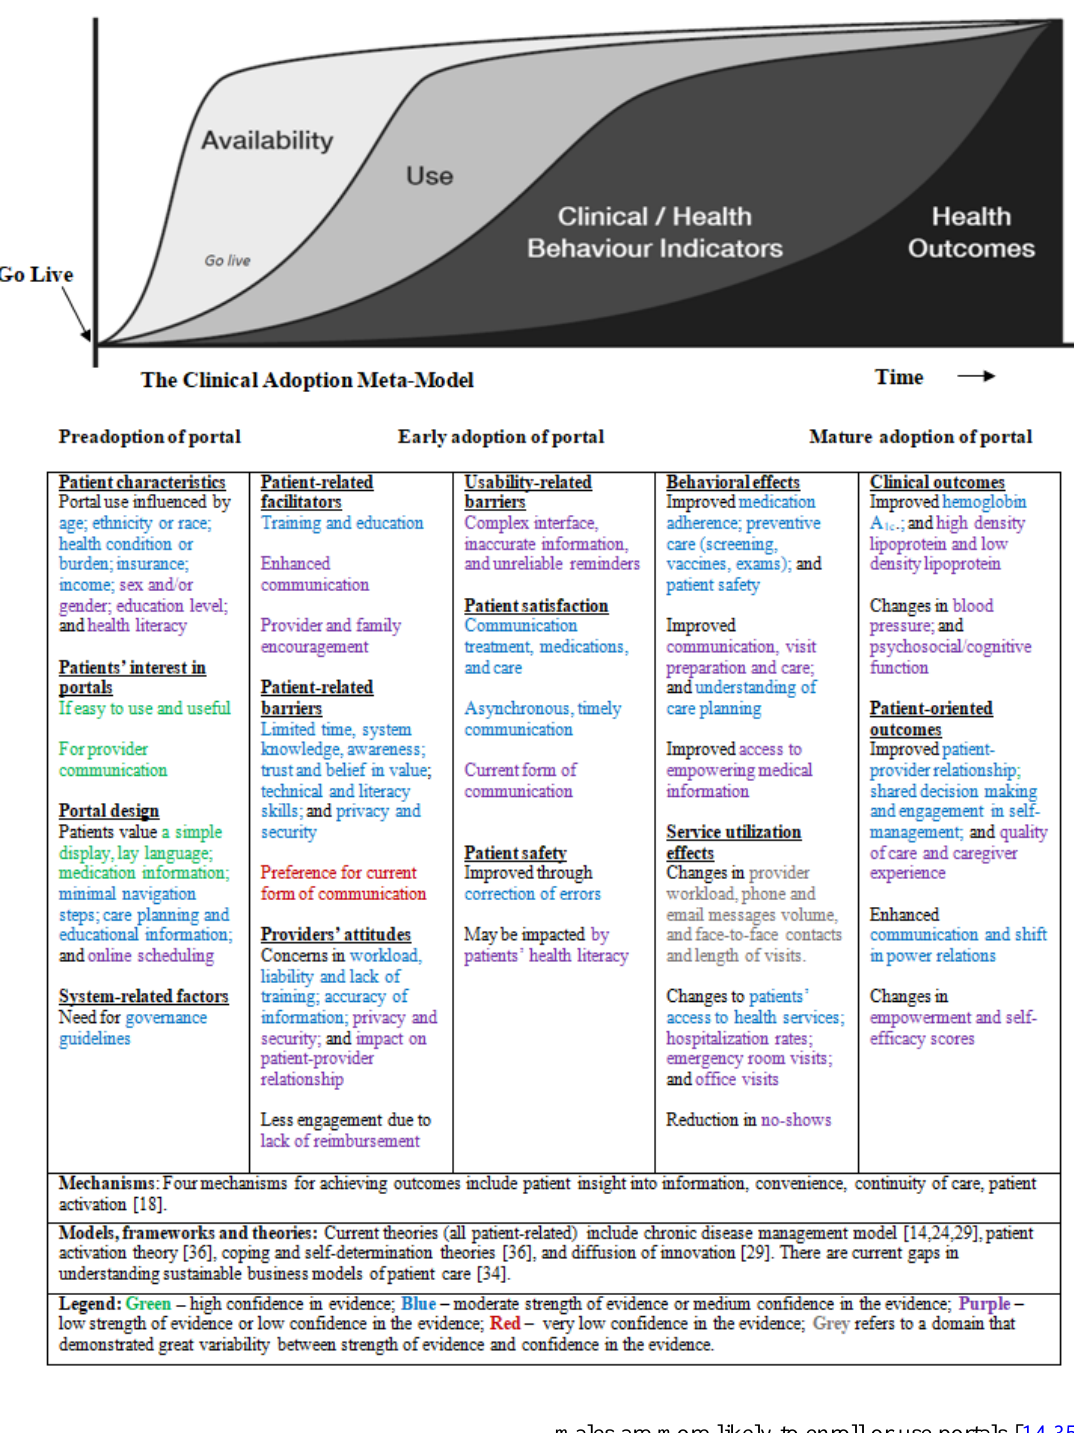
Figure 3. Evidence Map Across Portal Adoption